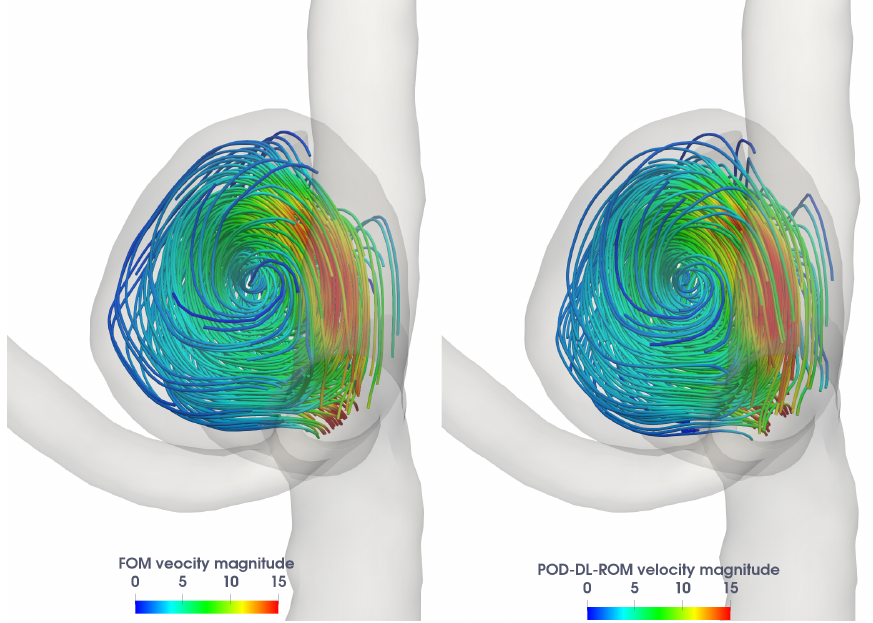
= ( 5.9102, 3.1179 ) at t = 0.18 s, test